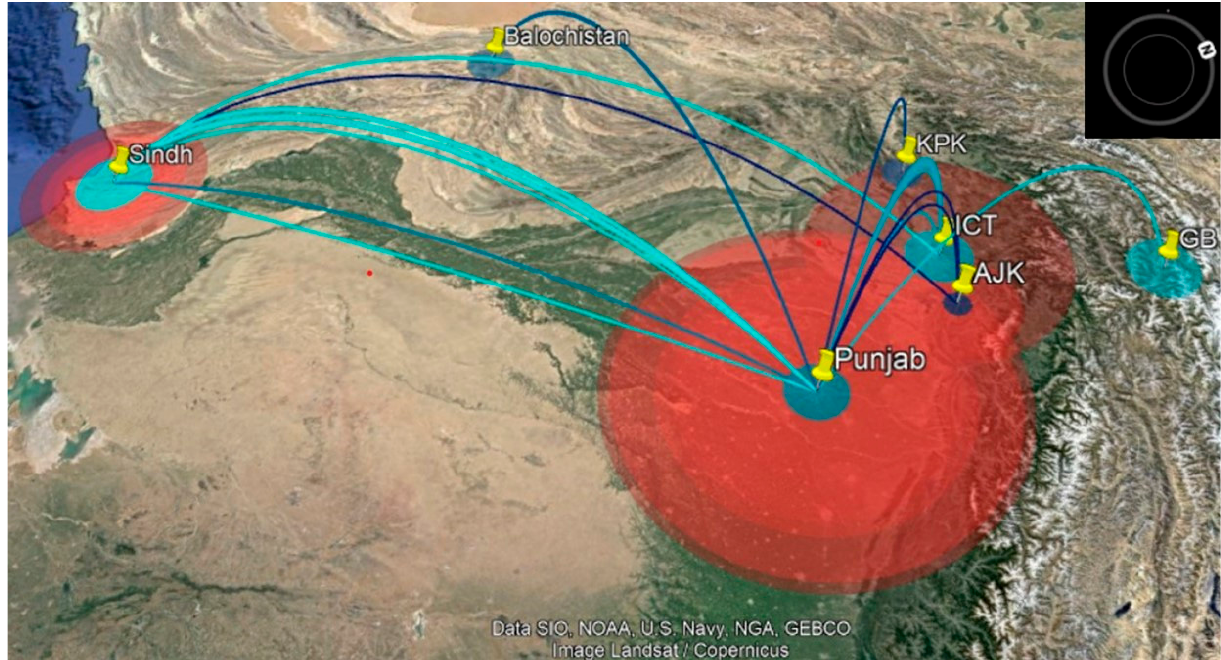
Figure 6. Visual reconstruction of spatiotemporal diffusion of FMDV serotype A viruses in Pakistan. The location-annotated MCC tree was used to depict the transmission of serotype A viruses between seven locations within the country. Each location is individually represented by a distinct color, and the route of transmission is represented by lines colored according to destination location or sink location. The polygons around each location represent the time spent by viruses in an area, along with the Bayesian confidence interval. Images rendered in Google pro-Earth; image: Landsat/Copernicus.